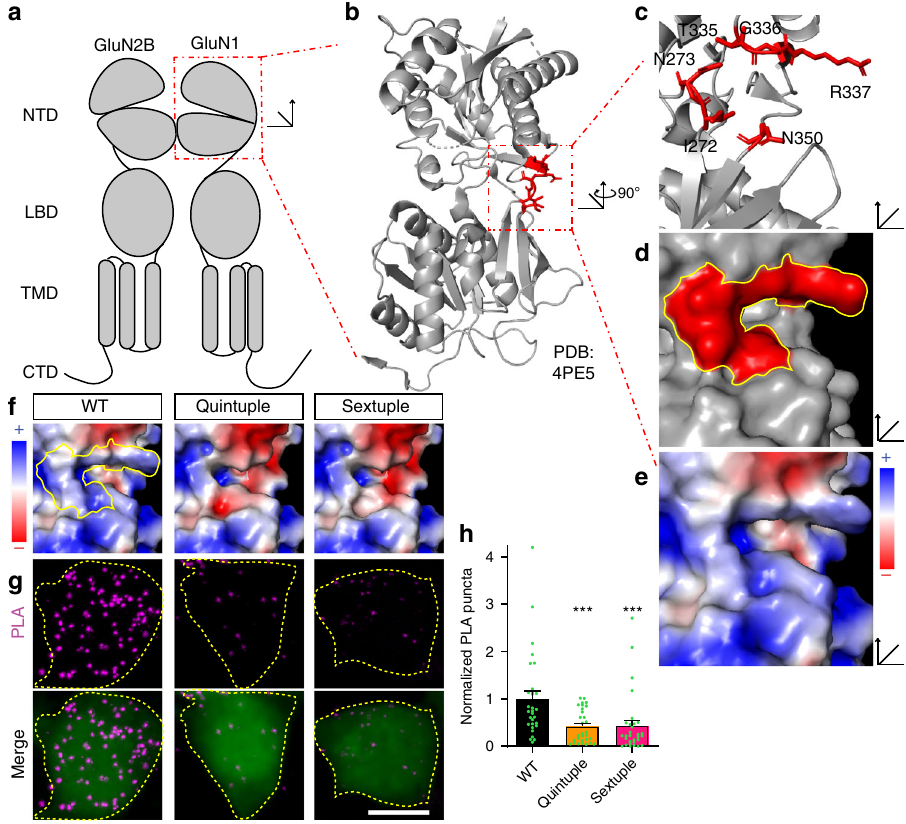
Fig. 2 GluN1 hinge mutants disrupt the EphB2 – GluN1 interaction in HEK293T cells. a A model of domain organization of the GluN1 and the GluN2B subunits of the NMDA receptor. The red box indicates the N-terminal domain (NTD) of GluN1. b The crystal structure of the NTD of GluN1 (PDB: 4PE5). The red box indicates the hinge region within the NTD with speci fi c amino acids highlighted in red. c The structure of the GluN1 NTD hinge region represented in cartoon form with the location of six amino acids highlighted in red (I272, N273, T335, G336, R337, N350). d The surface representation of the structure of the GluN1 NTD hinge region with the location of the six amino acids in c highlighted in red. e Charge map of the GluN1 NTD hinge region. The charge map was generated using the adaptive Poisson – Boltzmann solver (APBS) plugin in PyMOL. f Charge maps of GluN1 NTD hinge region mutants (WT, Quintuple, Sextuple). Yellow outline indicates the location of the six key hinge region amino acids in WT GluN1. g Representative images of the PLA assay results in HEK293T cells. HEK293T cells were transfected with either WT Myc-GluN1, Quintuple mutant Myc-GluN1 (I272A/N273A/T335A/ G336A/R337A), or Sextuple mutant Myc-GluN1 (I272A/N273A/T335A/G336A/R337A/350Q), and GluN2B, FLAG-tagged-EphB2, and EGFP. The upper panels show PLA signal alone. The lower panels are the merged images with EGFP in green and PLA signal in magenta. Scale bar = 10 µ m. h Quanti fi cation of the effects of GluN1 mutants on PLA puncta number. PLA puncta number are quanti fi ed by counting the number of puncta per 100 µ m 2 in EGFP + cells and normalizing to the WT condition (*** p < 0.005, ANOVA; green dots represent n = 30 cells for each